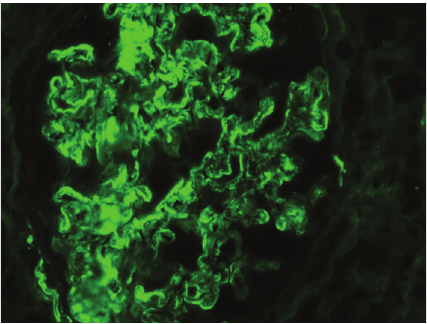
Figure 3: Immunofluorescence microscopy ( × 400) shows IgG band like capillary wall